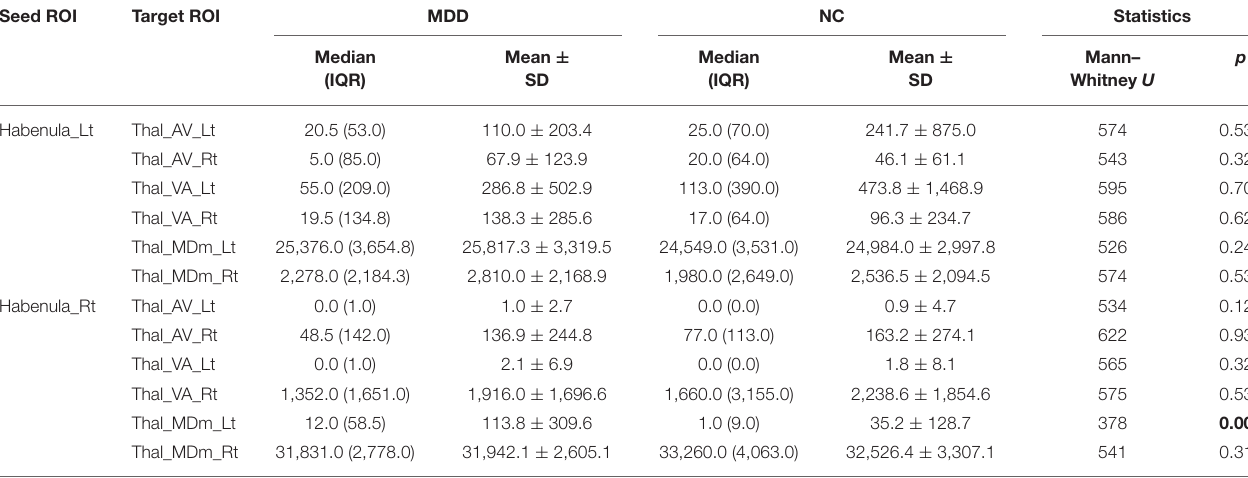
TABLE 2 | Comparison of the number of tracts from the habenula to the thalamus between patients with MDD and NCs. Seed ROI Target